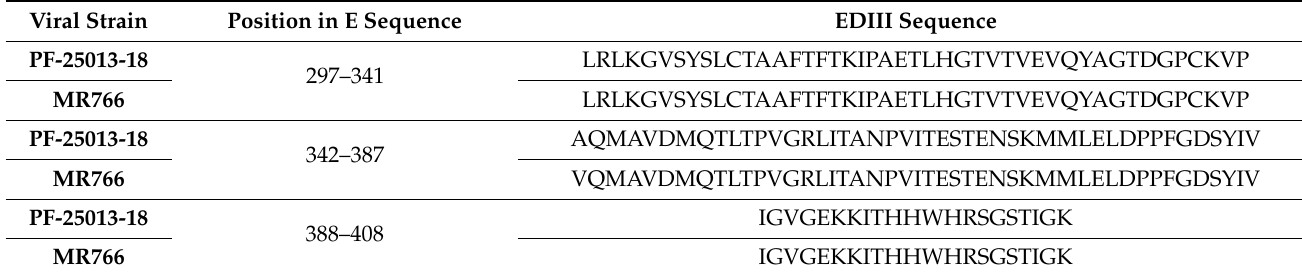
Table 2. Amino acid sequences of E protein domain III of South Pacific strain used for cloning compared to MR766 reference